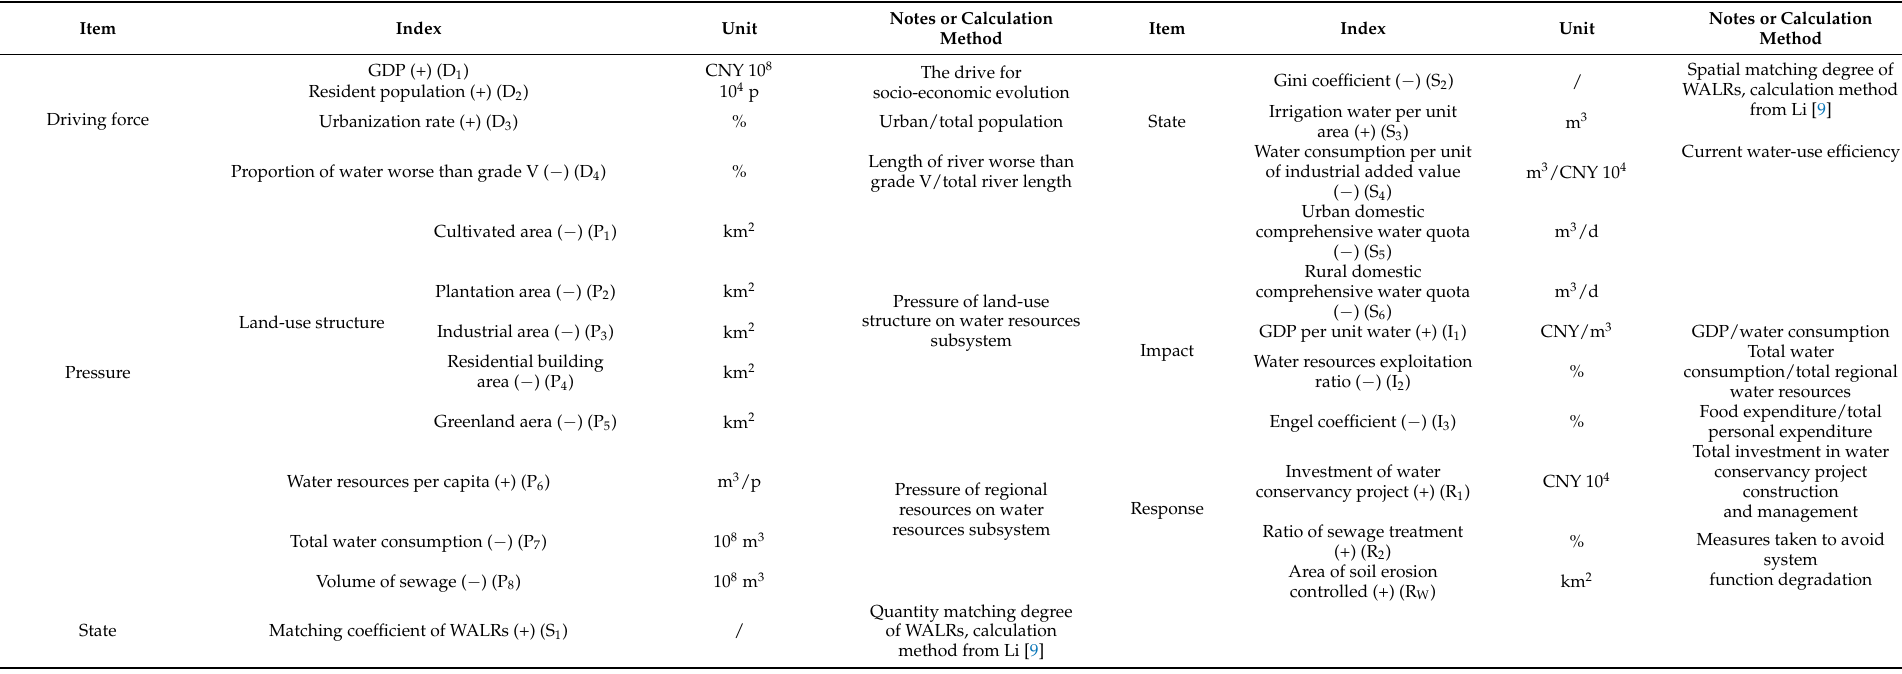
Table 1. Evaluation index system of the development level of water resources